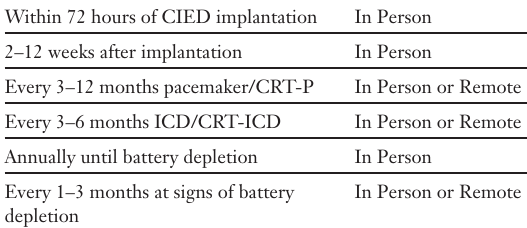
Minimum frequency of CIED in person or remote monitoring (HRS/EHRA